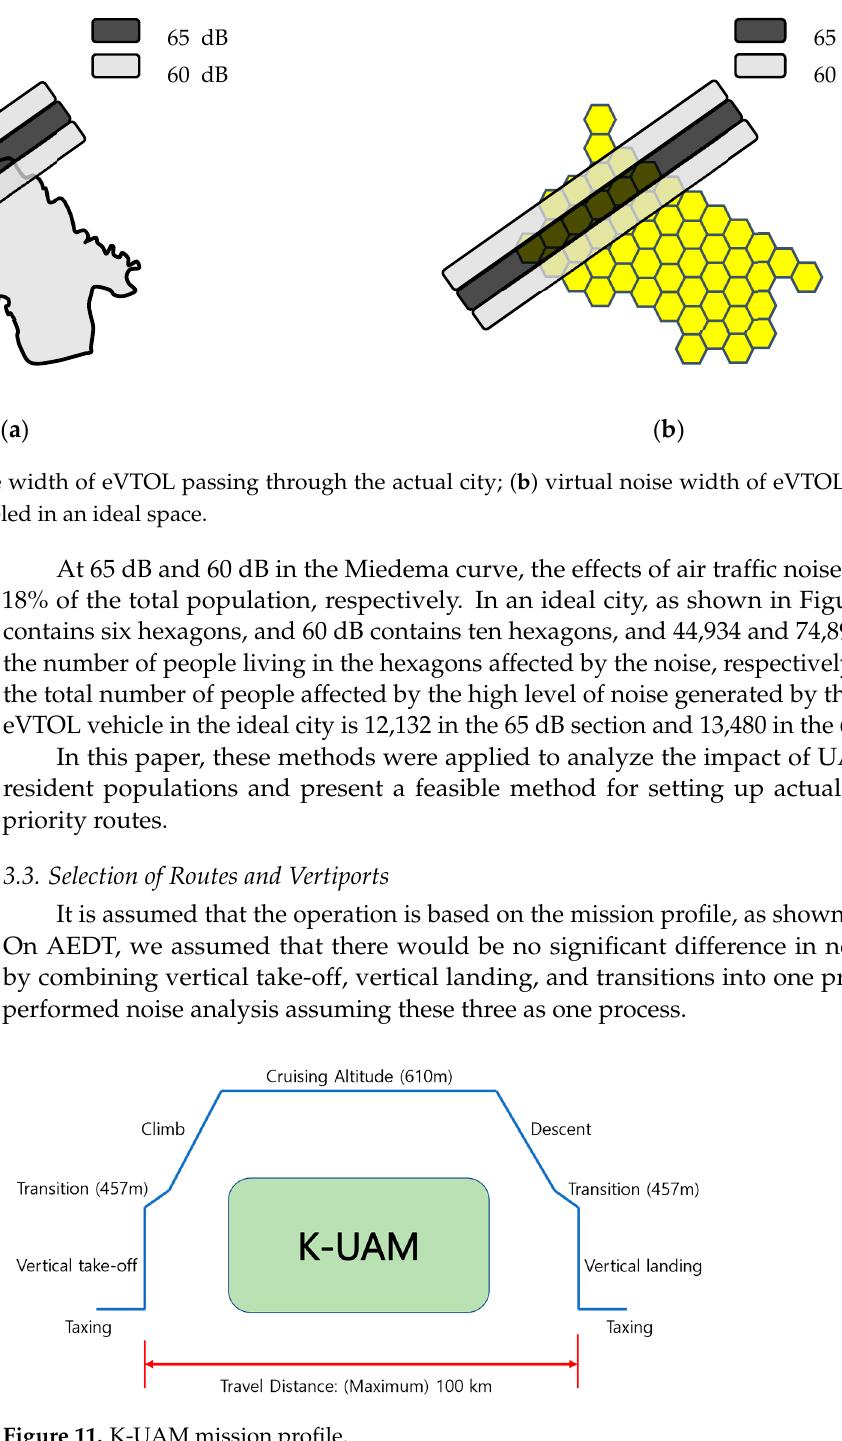
Figure 11. K-UAM mission profile.